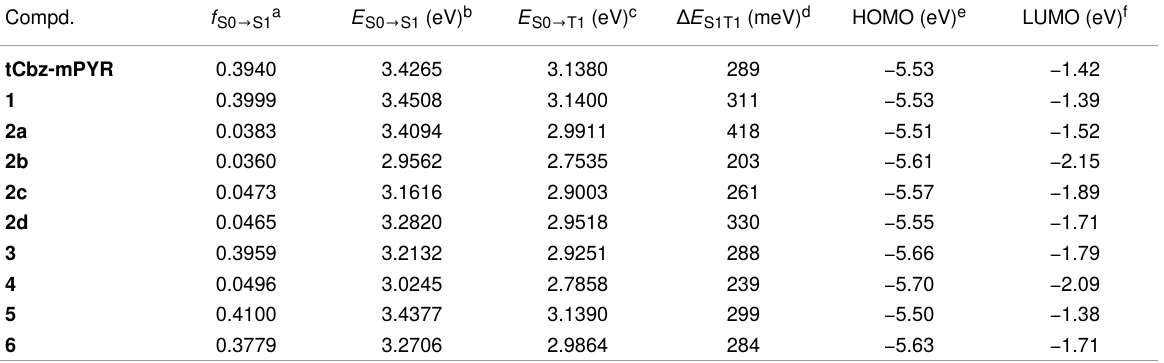
Table 1: DFT computed S 0 → S 1 /T 1 transition energies, oscillator strengths of S 0 → S 1 transitions, and Δ E ST values of carbazole–pyrimidine TADF compounds.